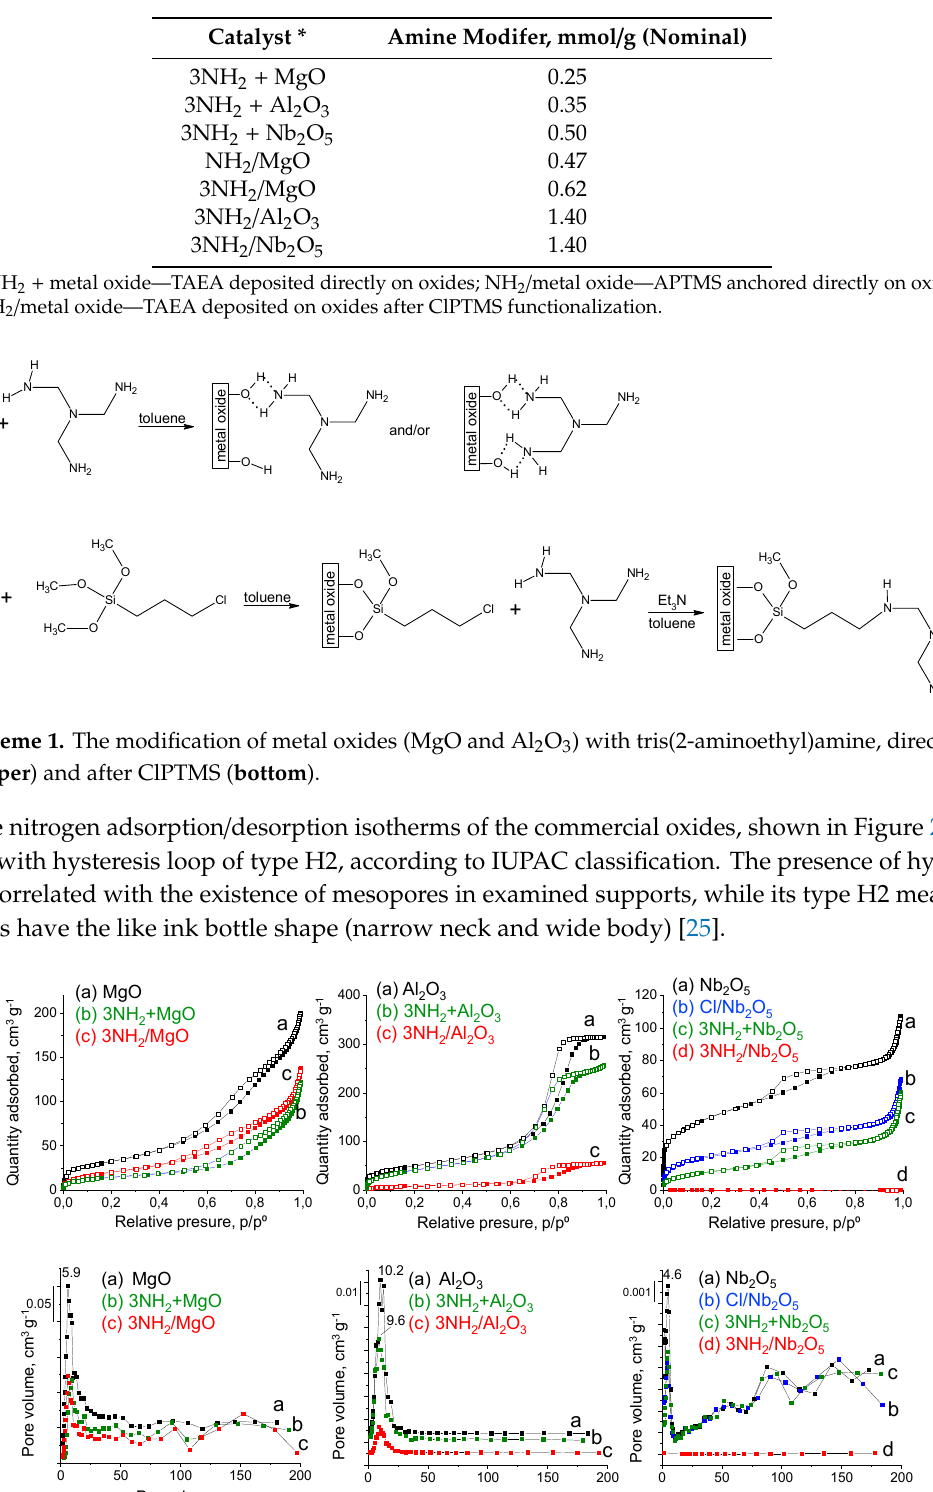
Table 2. Nitrogen content in the catalysts estimated from elemental analysis.